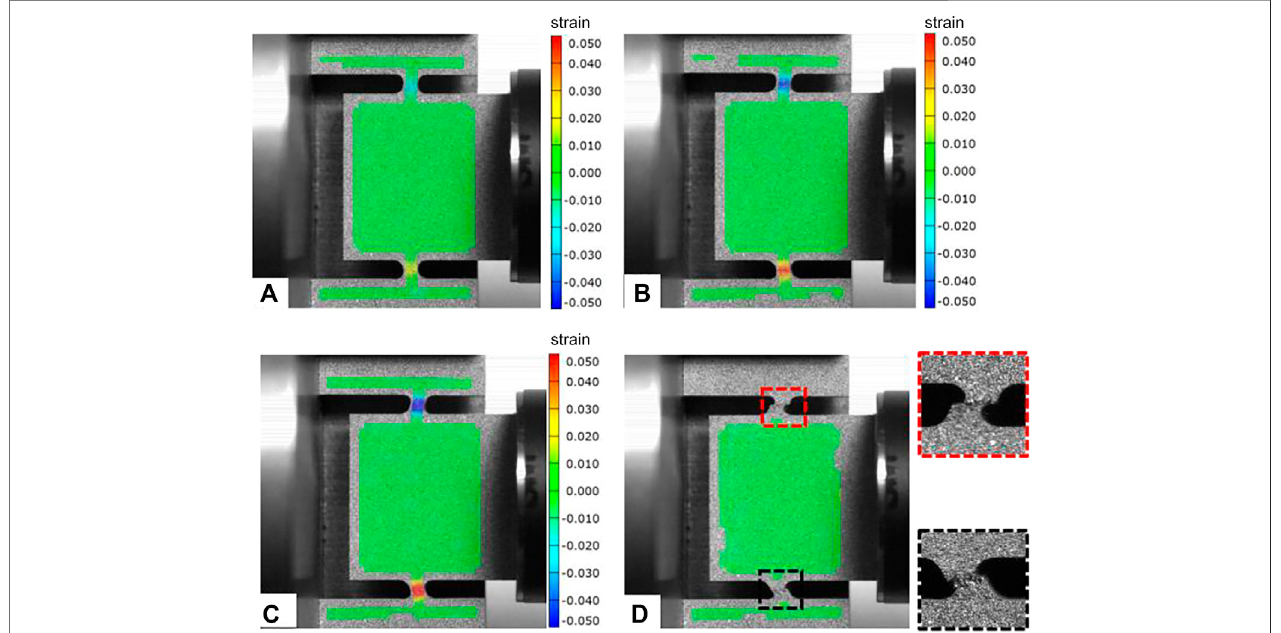
FIGURE 8 | Failure morphology of specimens with 2 mm welding length: (A) 1000 s − 1 , (B) 1500 s − 1 , (C) 1700 s − 1 and (D) 2000 s − 1 .